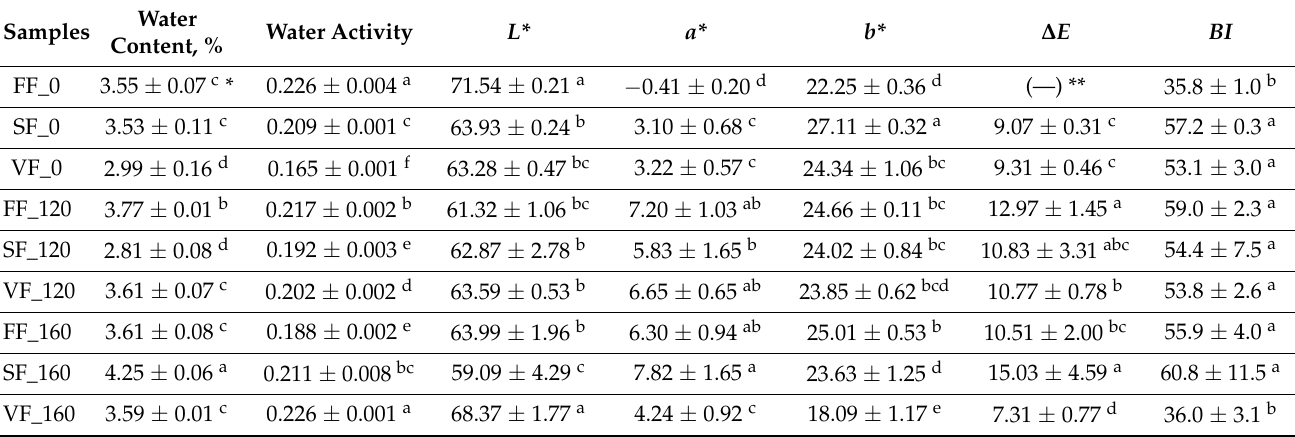
Table 3. The physical attributes of the freeze-dried apples obtained with different pre-treatment and freezing